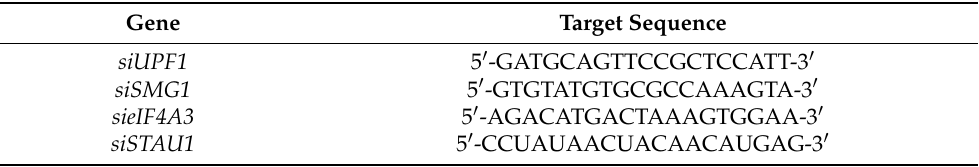
Table 1. siRNA target sequences used for the transfections.